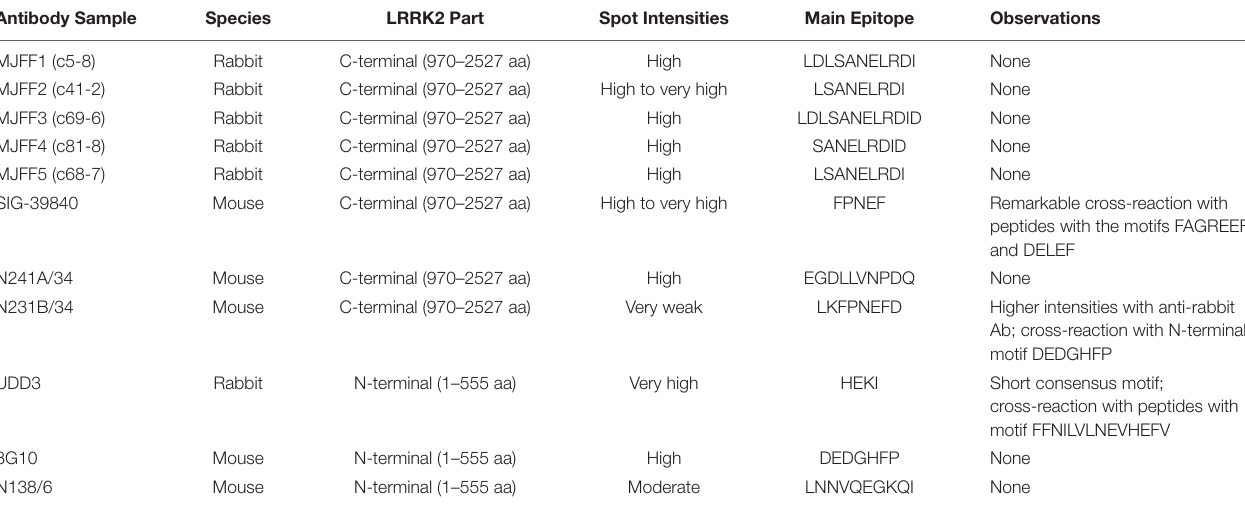
TABLE 1 | Epitope mapping data showing the main epitopes of commercially available total LRRK2 monoclonal antibodies. Antibody